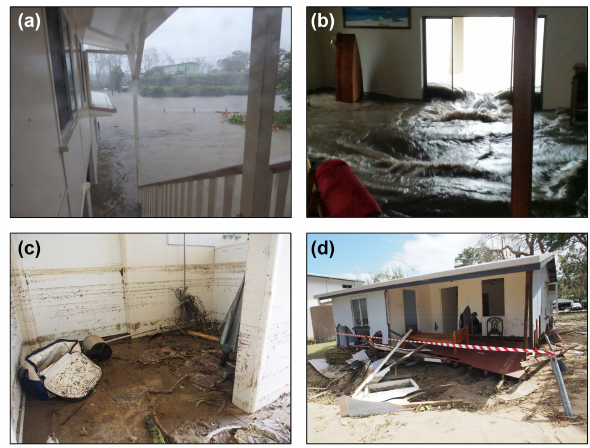
Figure 10. Flooding (a) , water ingress (b) , interior (c) and exterior (d) damage to property at Wilson Beach. (c) and (d) are authors’ own images; (a) and (b) were taken by residents at Wilson Beach, reproduced with their permission for this